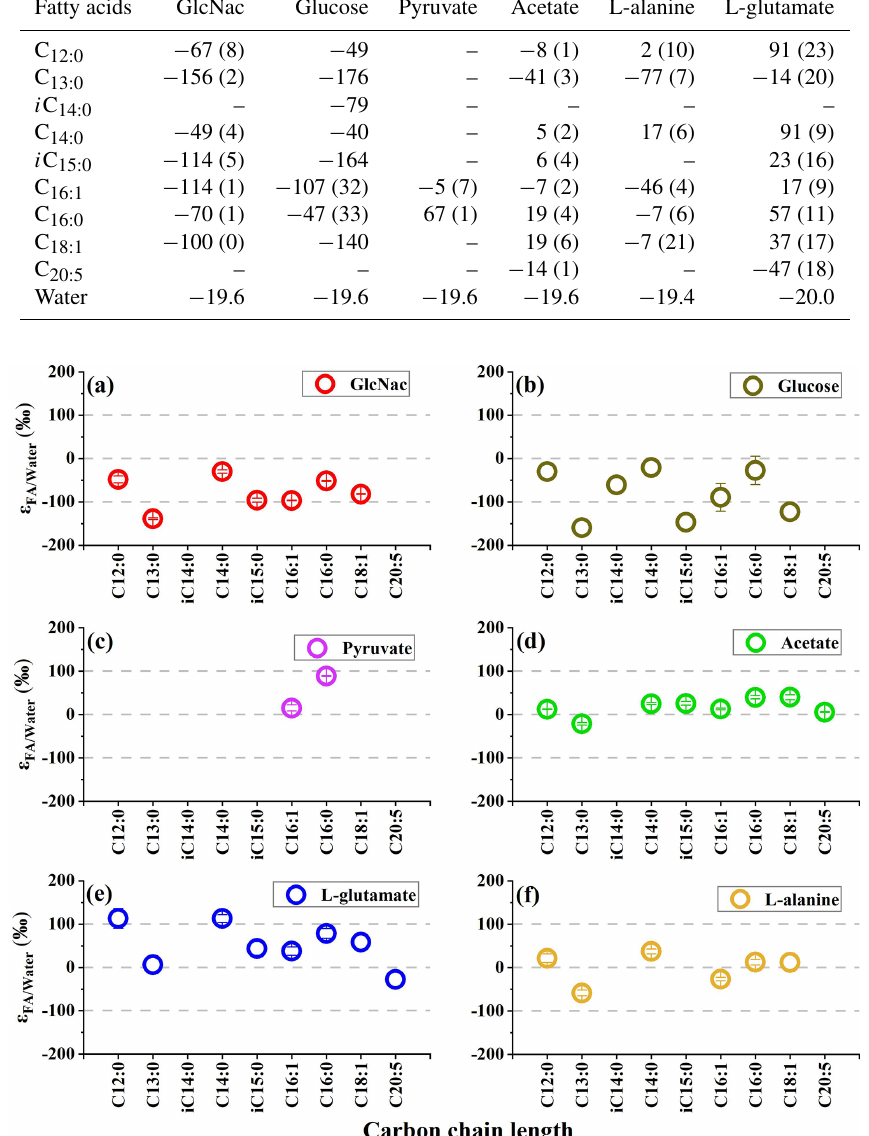
Table 1. The hydrogen isotopic values of fatty acids in S. piezotolerans WP3 growing on different organic substrates at 20 ◦ C and shaking at 200rpm; “–” indicates that the concentrations are too low for δ 2 H measurements. Standard deviations of two duplicate cultures are given in parentheses.